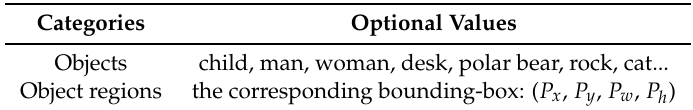
Table 1. Possible objects and object regions contained in raw